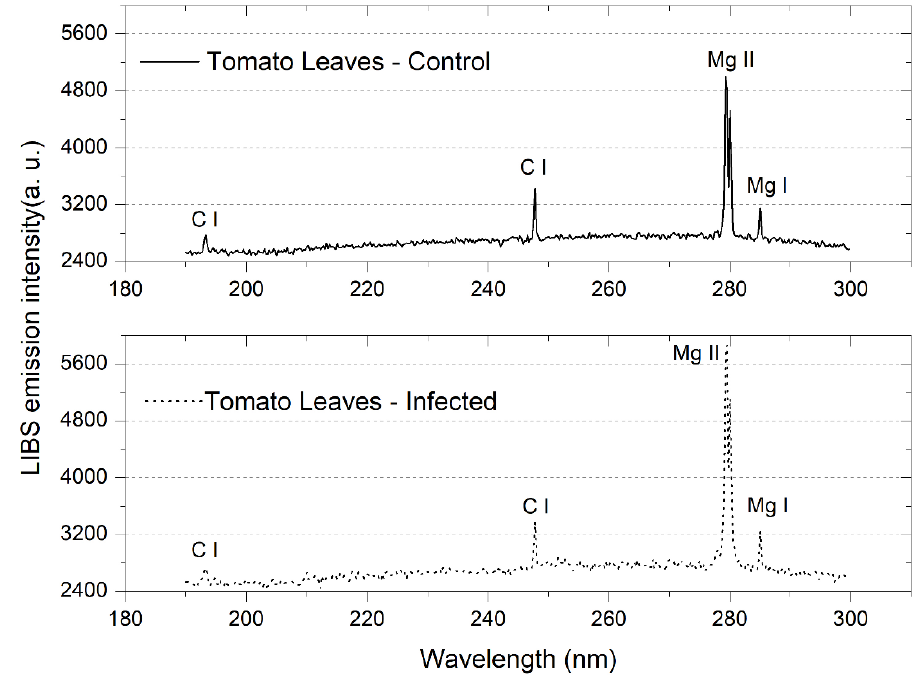
Figure 4. LIBS spectra of tomato leaves of uninfected plants and plants with roots infected by M. incognita .